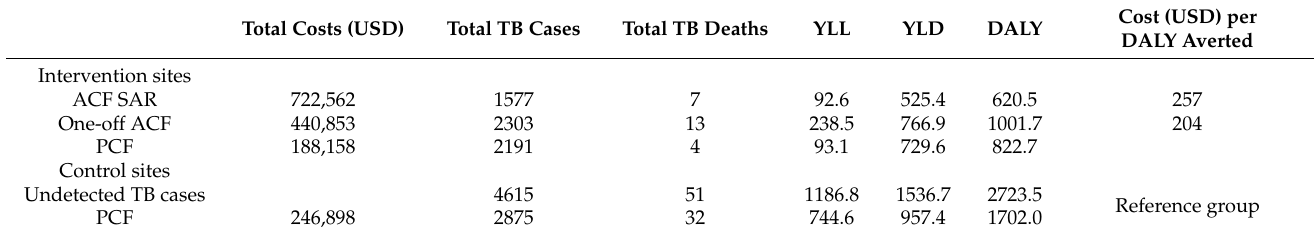
Table 4. Incremental cost-effectiveness ratio of ACF models.